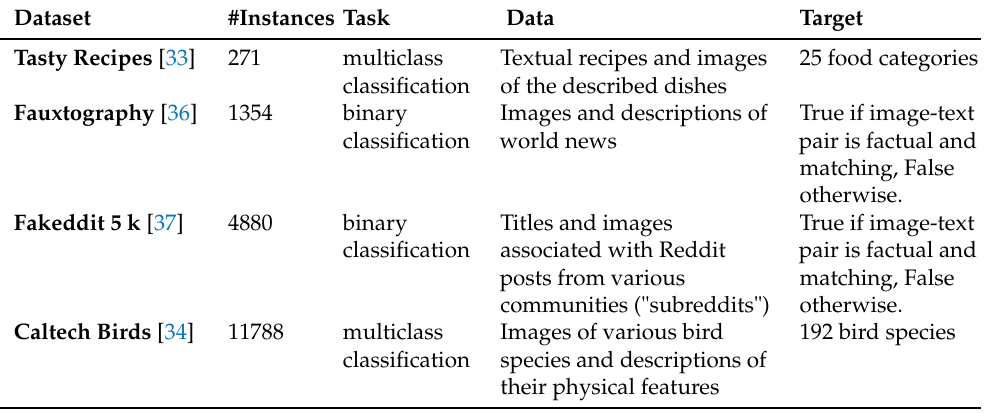
Table 2. Overview of the used multimodal datasets, including their size, task, and a description of the